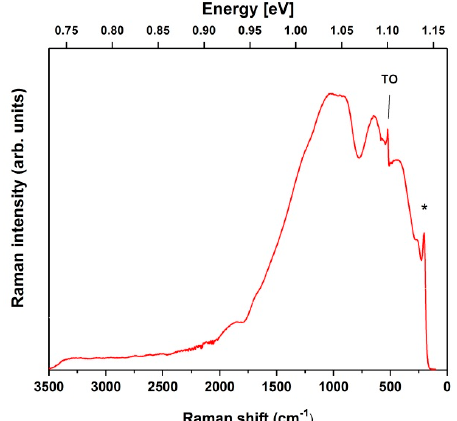
Figure 1. FT-Raman spectrum of pSi on top of highly doped cSi substrate. The band at ~520 cm − 1 due to the transverse optical phonons (TO) is shown. The band marked with an asterisk represents instrumental artifact.